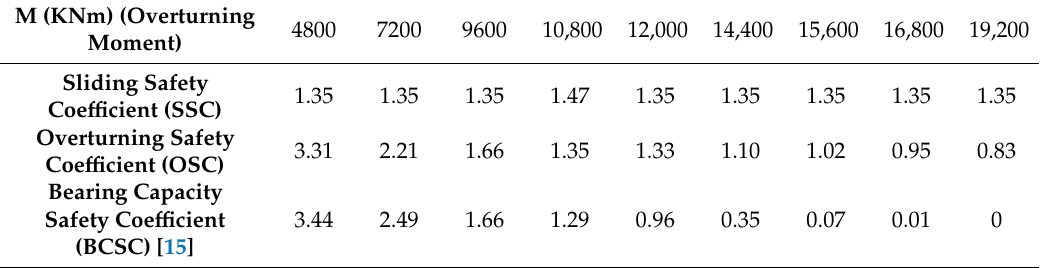
Table 3. Coe ffi cients obtained for load state Table 3. Coefficients obtained for load state C.